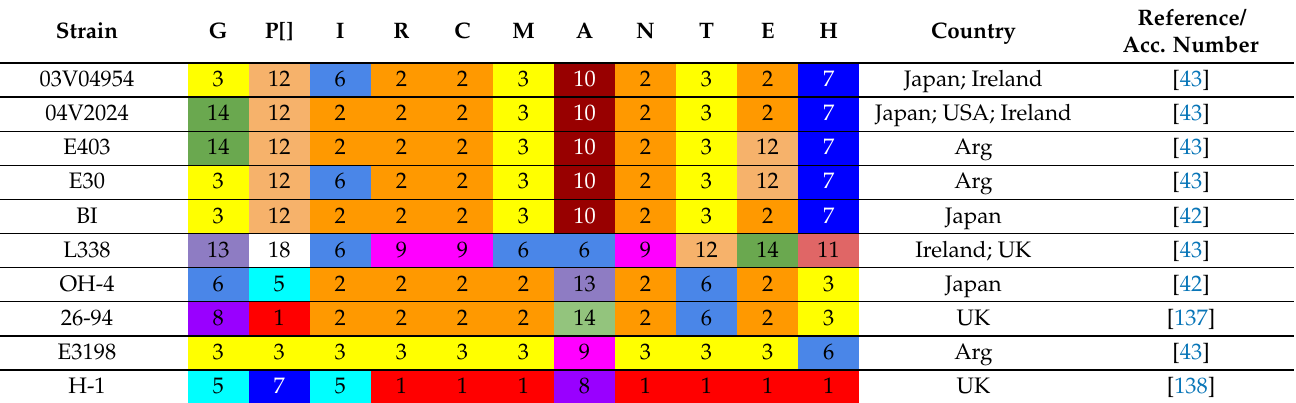
Table A5. Horse constellations.